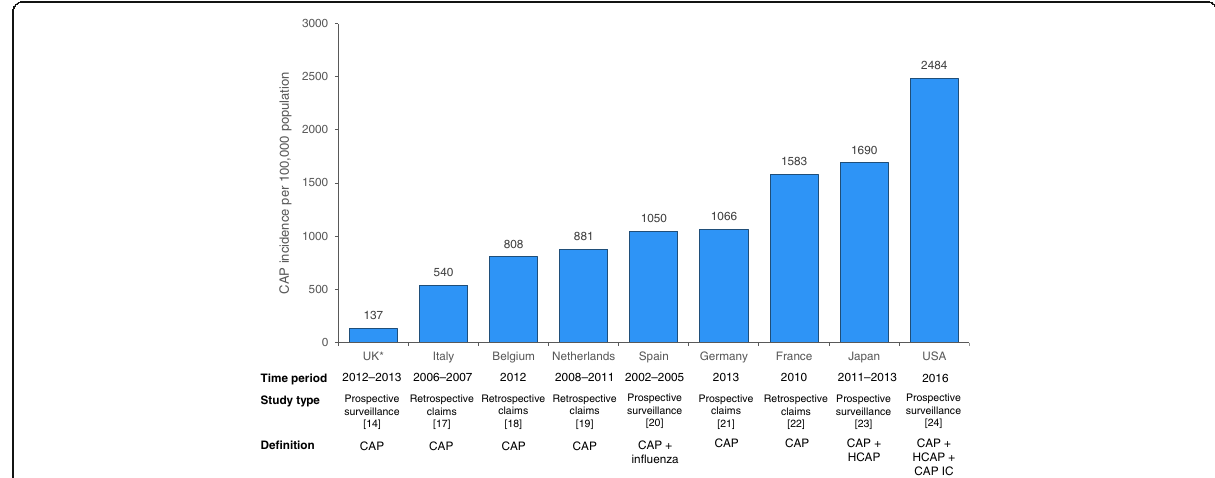
Fig. 1 Incidence rates of CAP around the world. *Age group 65 – 74 years only. CAP, community-acquired pneumonia; CAP IC, community- acquired pneumonia in children; HCAP, healthcare-acquired